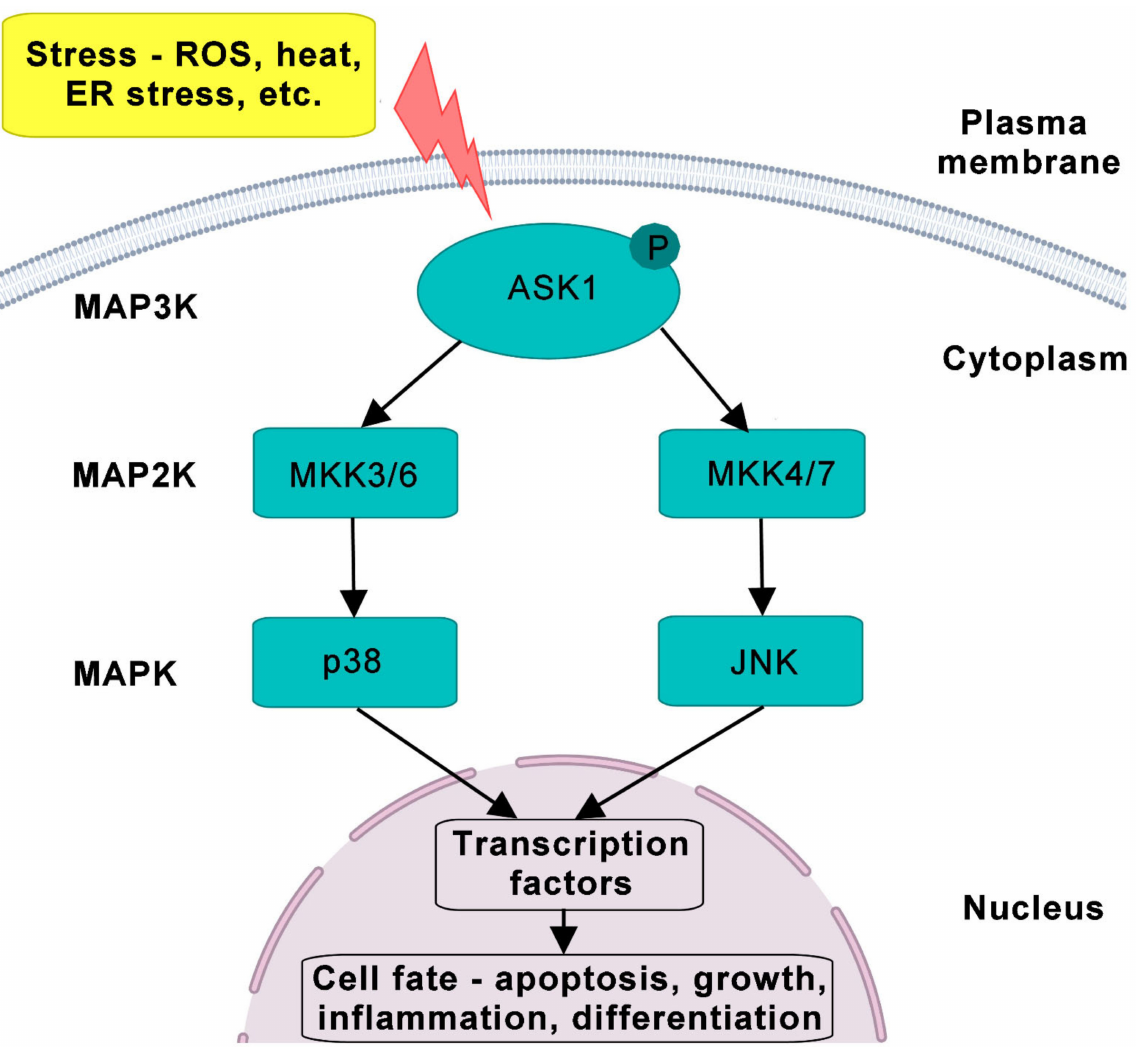
Figure 1. The MAPK cascade and its components. After various stresses such as ROS, ER stress, heat and bacterial infection, the activated form of ASK1 (MAP3K) activates MAP2K (MKK3/6 and MKK4/7) and consequently MAPK including p38 and JNK. All MAPKs are present in cytoplasm and can be shuttled to the nucleus to catalyze the phosphorylation of many proteins and transcription factors. The ASK1 pathway governs the cellular fate, such as apoptosis, growth, inflammation and differentiation. MAPK, mitogen-activated protein kinase; ROS, reactive oxygen species; ER, endoplasmic reticulum